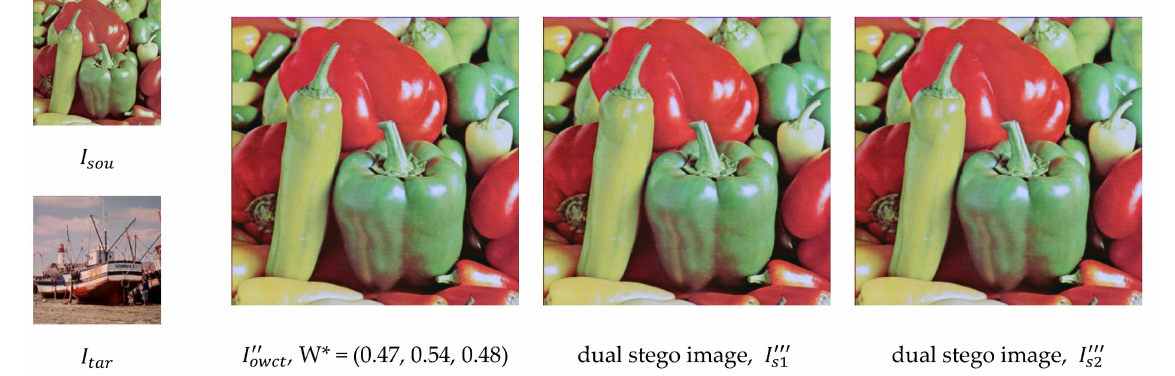
Figure 7. The visual inspection of the test image